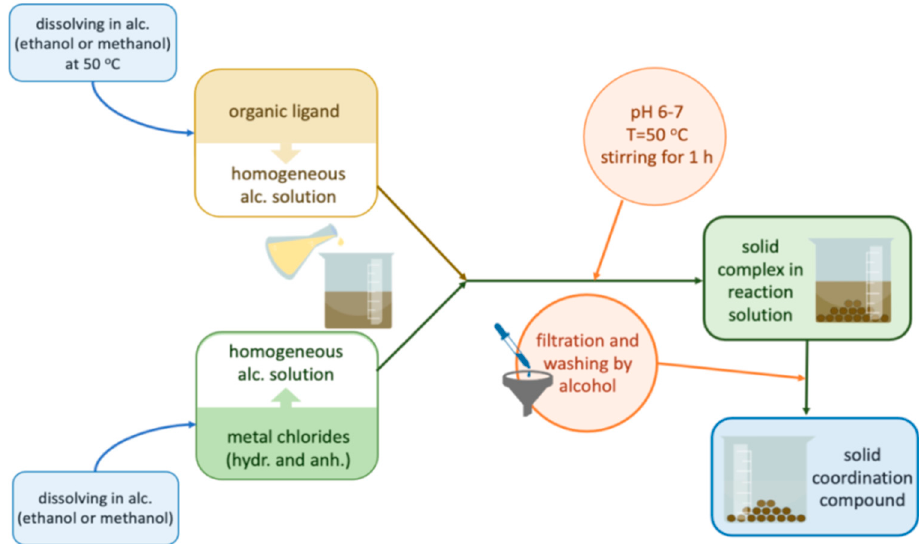
Figure 10. Synthesis route of the investigated complexes.